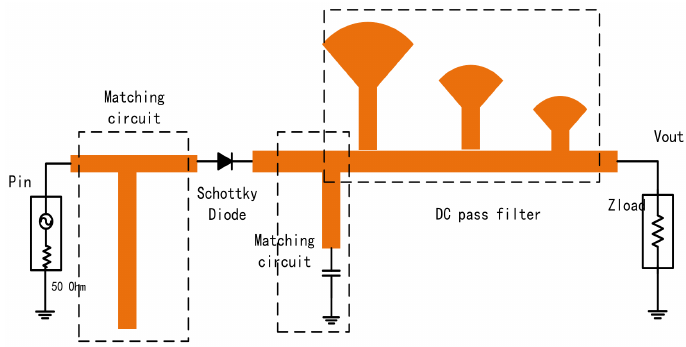
Figure 5. Structure diagram of the single microwave rectifier circuit.